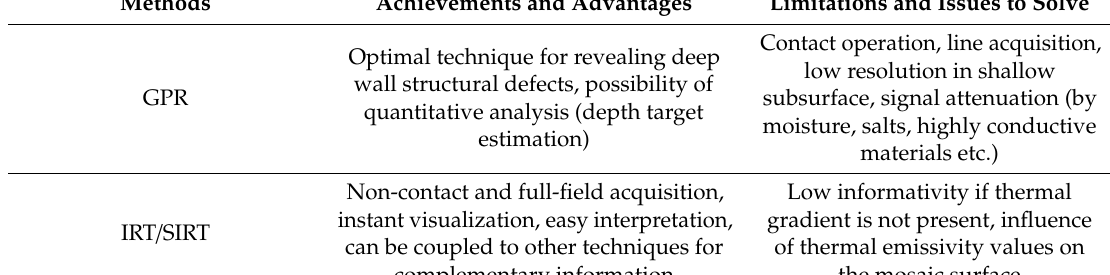
Table 2. Advantages and limitations of portable NDT for precious wall